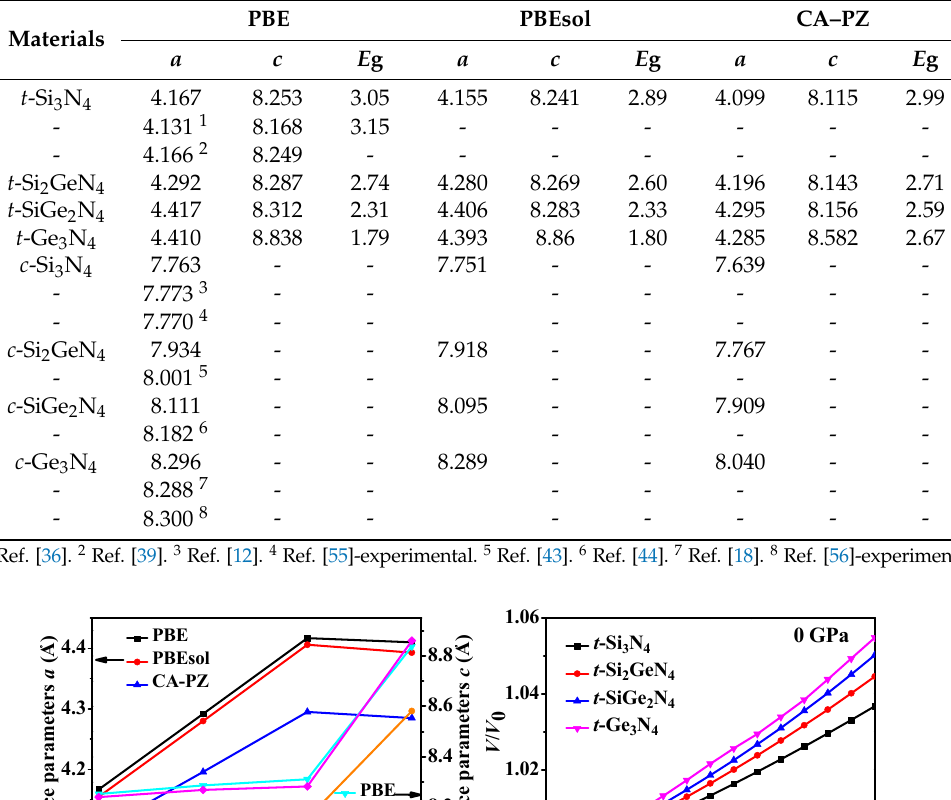
Table 1. The lattice parameters a and c (in Å ) and band gaps E g (in eV) of t -Si 3 N 4 , t -Si 2 GeN 4 , t -SiGe 2 N 4 , and t -Ge 3 N 4 and c -Si 3 N 4 , c -Si 2 GeN 4 , c -SiGe 2 N 4 , and c -Ge 3 N 4. PBE: Perdew–Burke–Ernzerhof functional; PBEsol: Perdew–Burke–Ernzerhof functional for solids; CA–PZ: Perdew and Zunger.